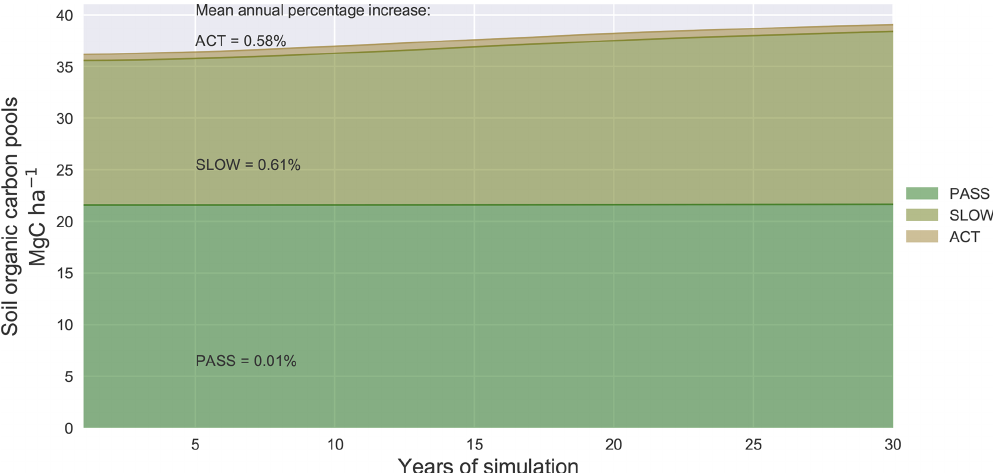
Figure 7. Sites average soil organic carbon pools (ACT: active; SLOW: slow; PASS: passive) evolution (MgCha − 1 ) over the 30 years of simulation to reach the 4p1000 target. In the graph the mean percentage increase is given for each SOC pool.